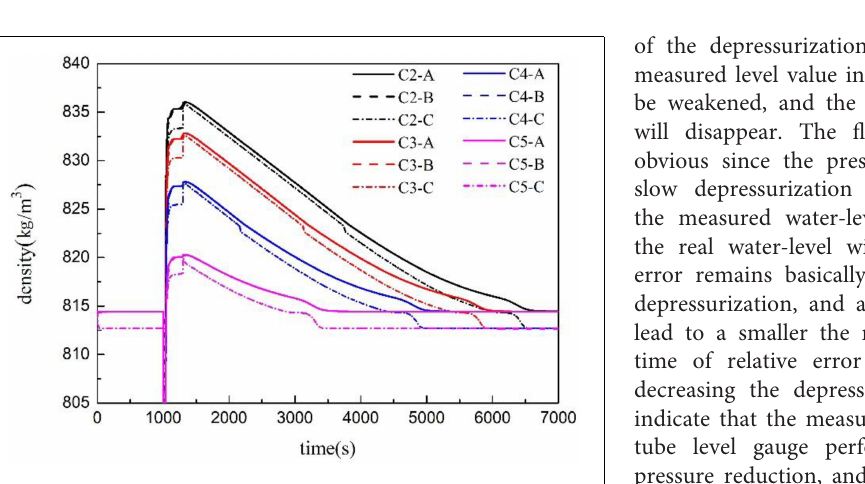
FIGURE 11 | Density of each pressure measuring